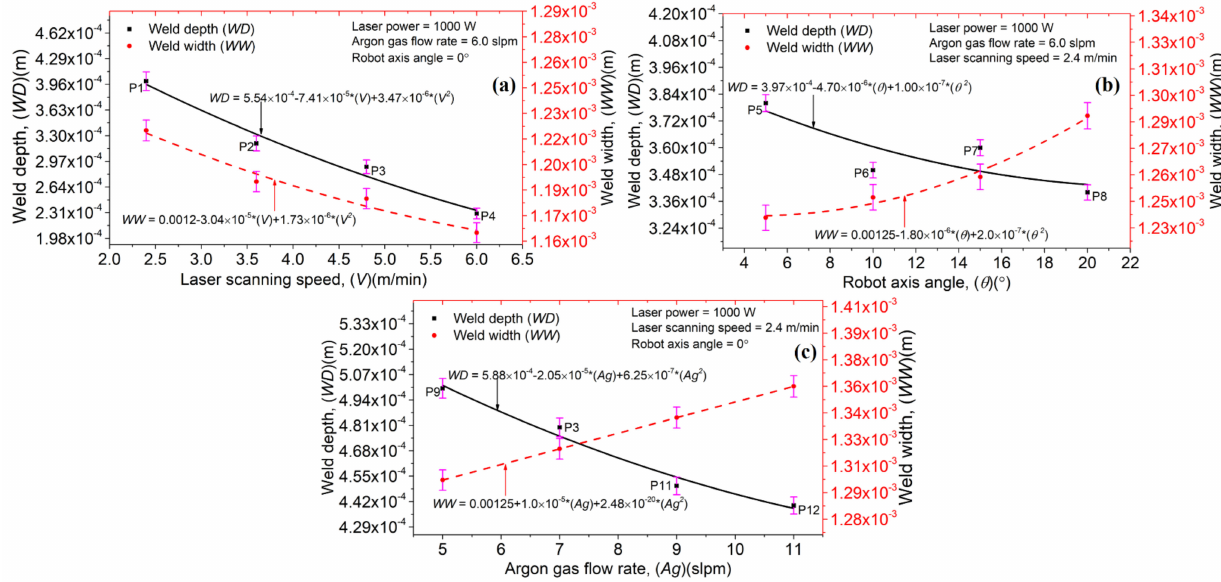
Figure 5. Laser welds’ depth and width by changing: ( a ) laser scanning speed, ( b ) robot axis angle, and ( c ) argon gas flow rate.